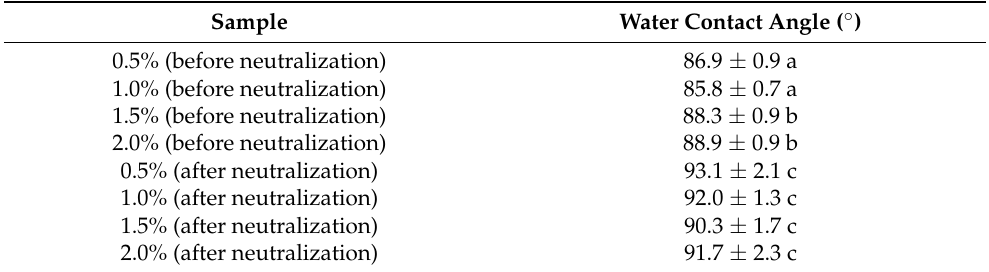
Table 2. Effects of chitosan concentration on water contact angles of chitosan films before and after neutralization.